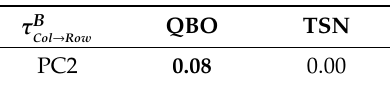
Table 11. IF τ B values between PC2 and the low-frequency climate indices (bold font indicates Col → Row statistically significant values at the 5% level).